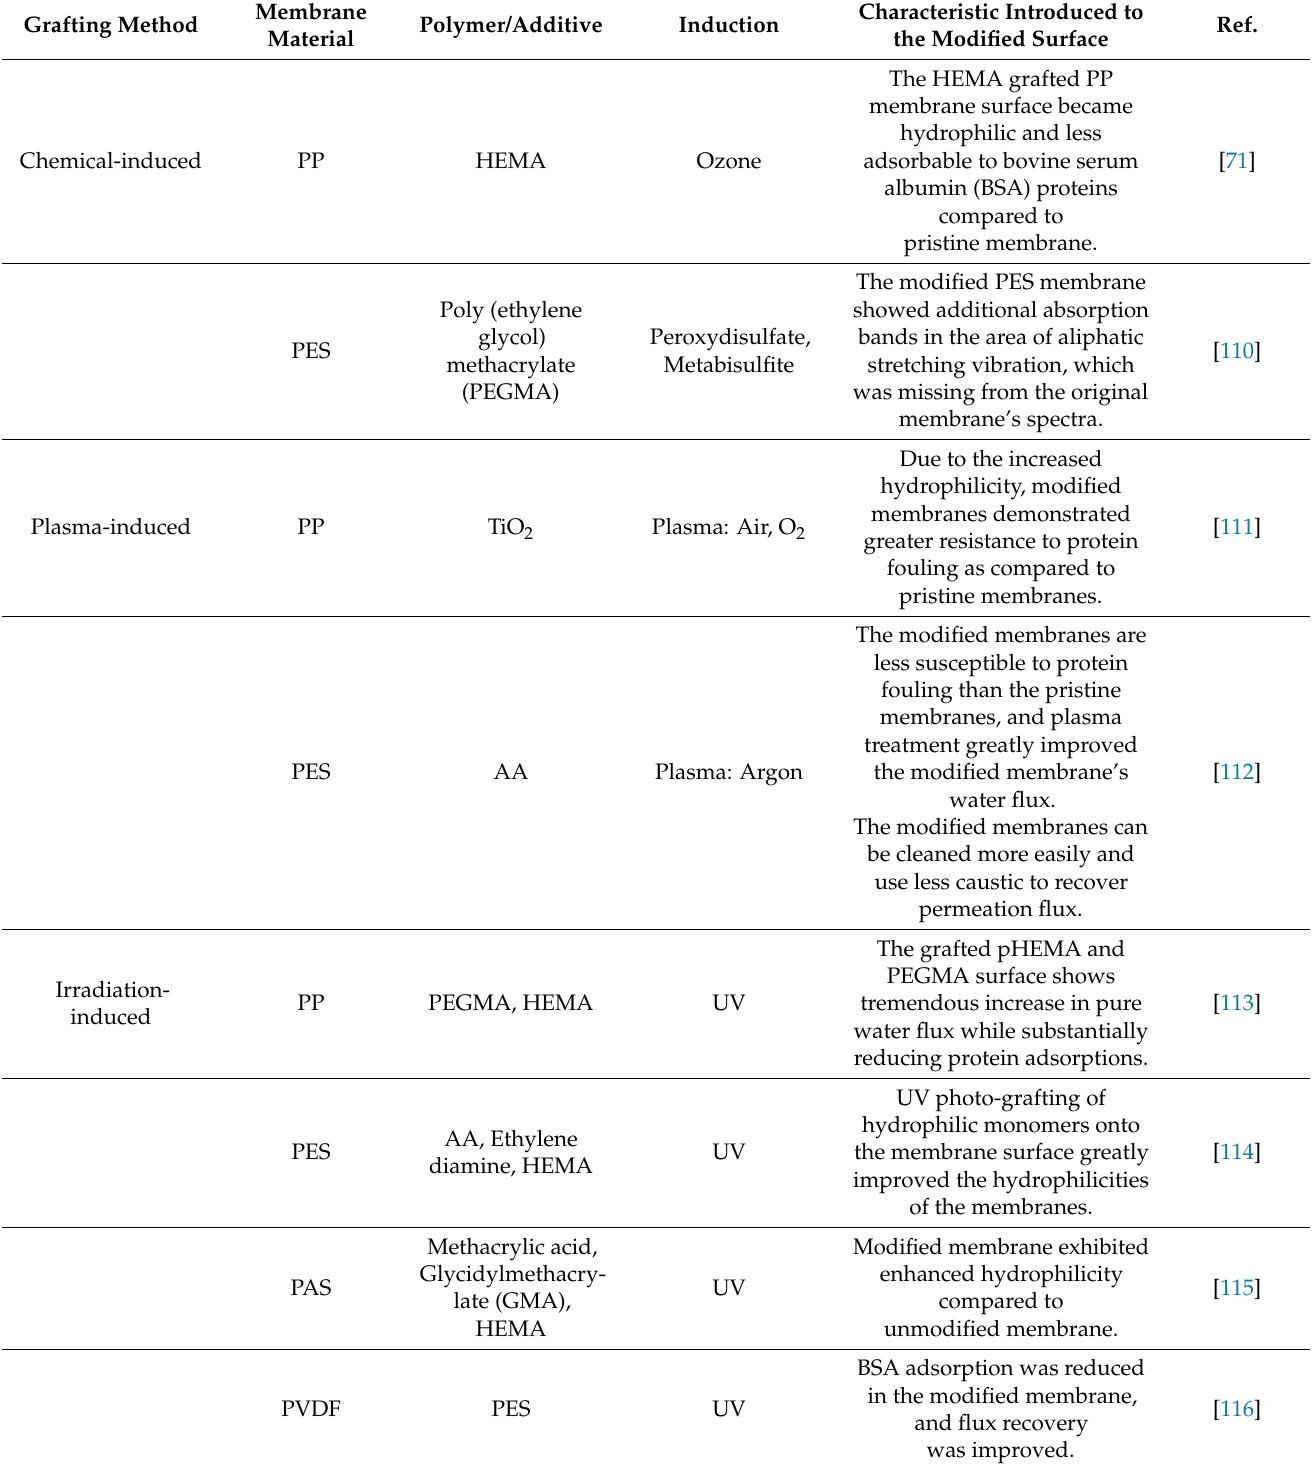
Table 1. Graft polymerization of polymeric